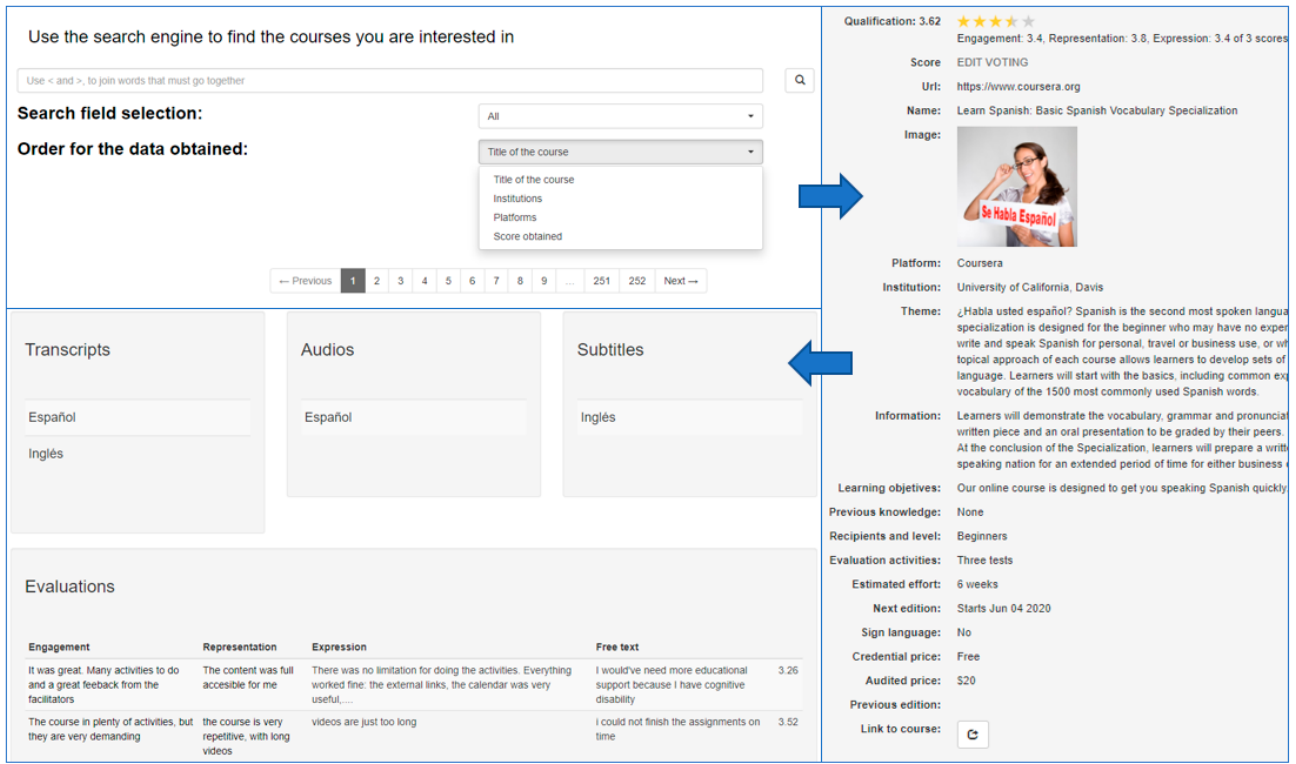
Figure 1. YourMOOC4all key functionalities.